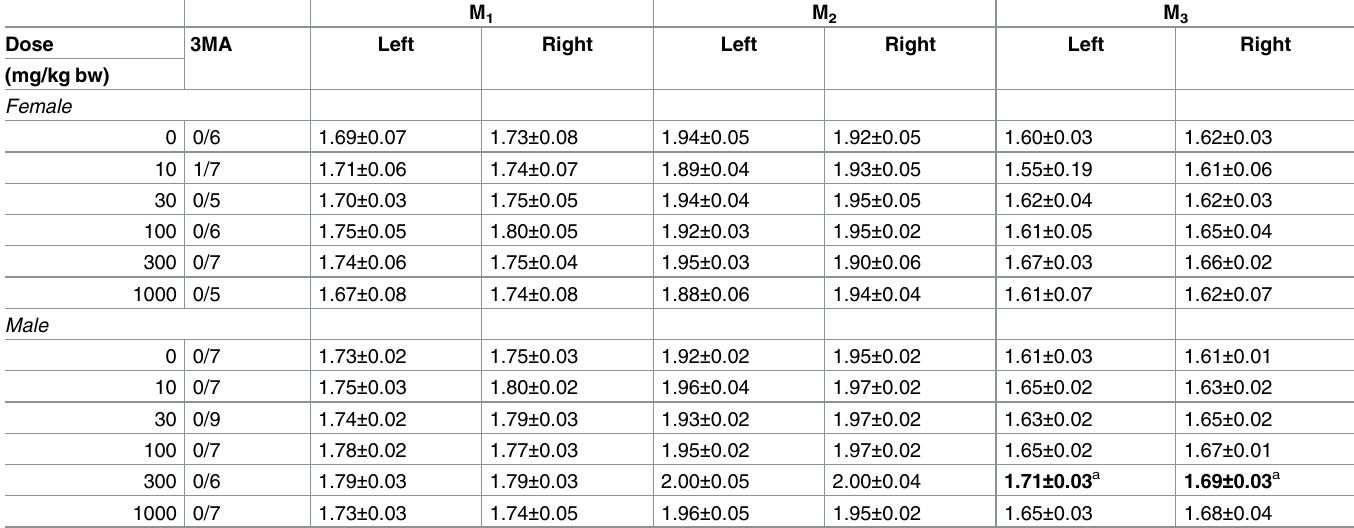
Table 6. Third molar agenesis frequency and maximum buccolingual diameter (mean ± SD, mm) for mandibular molar teeth in female and males rats by total dose of PCB 180. M 1 M 2 M 3 Right Left Right Left